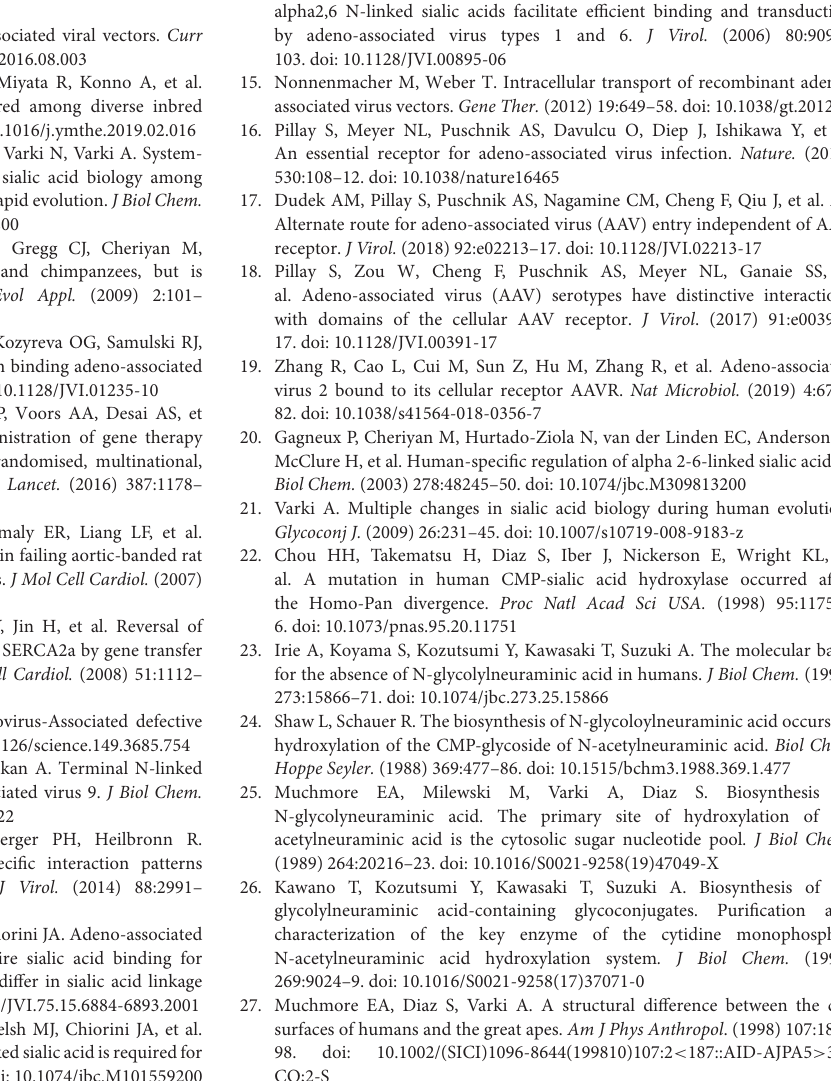
Supplementary Figure 1 | Neu5Gc staining of tissue sections of wild-type C57BL/6J (WT) or CMAH knockout (CMAH − / − ) mice. Neu5Gc staining (blue) was performed on 6 µ m paraffin-embedded heart, liver, skeletal muscle, brain, kidney or lung sections from male (A) and female (B) WT and CMAH − / − mice with chicken anti-Neu5Gc antibody (cat. no.: 146903, BioLegend) or chicken IgY Isotype control (cat. no.: 402101, BioLegend) both at 1 ug/mL. Biotinylated goat anti-chicken IgY antibody (cat. no.: BA-9010, Vector Laboratories) was used as a secondary antibody. Nuclei were counterstained with VECTOR Nuclear Fast Red (red). Representative images are shown for each organ [ n = 2 mice per group; magnification 10 × (left panels) or 20 × (right panels)]. Scale bars 100 µ m (left panels) or 50 µ m (right panels) for each organ. Supplementary Figure 2 | Lectin blotting analysis of sialic acid (SIA)-containing glycoproteins in mouse tissue protein extracts. Lectin staining was performed to